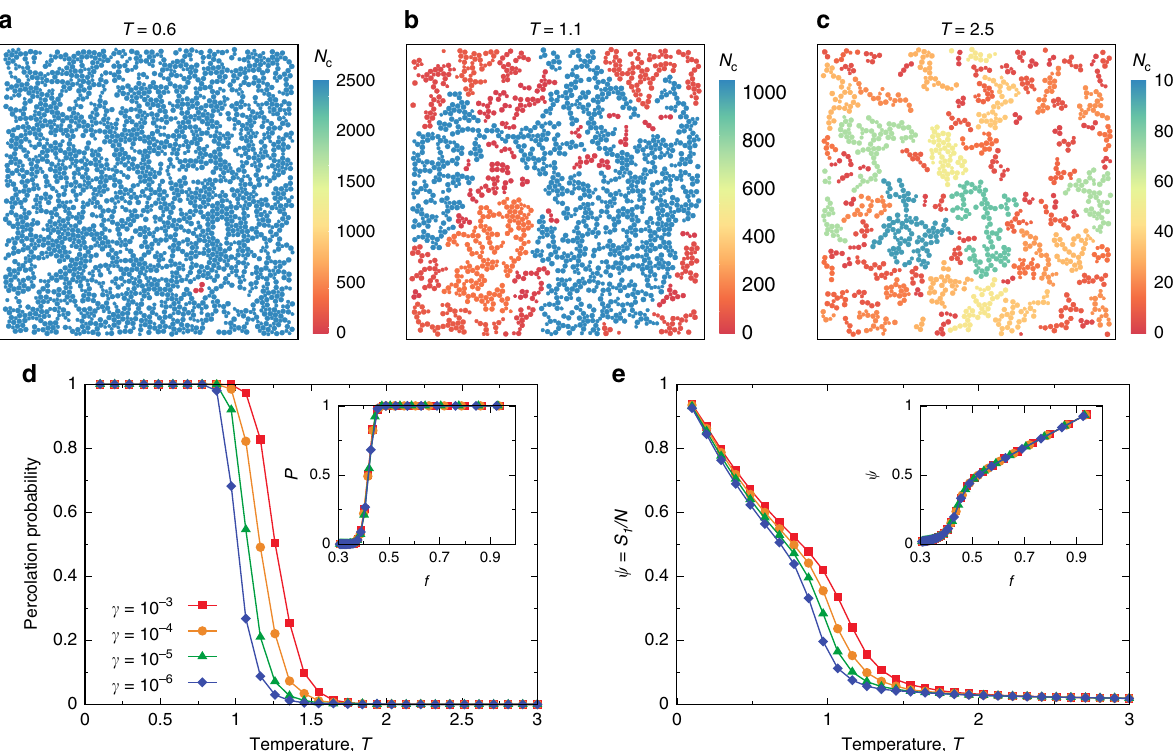
Fig. 3 Percolation of force-bearing particles across the nonequilibrium glass transition. a – c Spatial distribution of force-bearing particles at different temperatures in the solid phase ( a ), at the critical temperature ( b ), and in the liquid regime ( c ). Con fi gurations are from a cooling rate of γ = 10 − 4 . Particles in the same force-bearing network are clustered and coloured according to the cluster size N c . Clusters with <3 particles are not shown for clarity. d Temperature dependence of percolation probability P for different γ . The γ -dependent nonequilibrium glass transition is signalled by the percolation of force-bearing particles. Inset: Collapse of P from different γ when replotted as a function of the fraction of force-bearing particles f . e Temperature dependence of the relative size of the largest force-bearing cluster ψ = s 1 / N for different γ , with s 1 being the number of particles involved in the largest cluster. A strong similarity can be seen in comparison with the integrated stress-stress correlation in Fig. 1c. Inset: Collapse of ψ from different γ when replotted as a function of f . Therefore, while the percolation of force-bearing particles is controlled by T with different functional forms depending on γ , it is uniquely determined by f